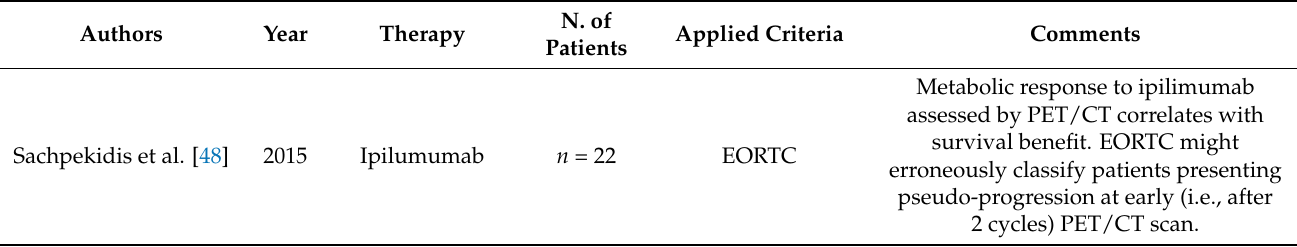
Table 4. Summary of main studies on 18 F-FDG PET/CT for response assessment to immunotherapy with ICIs in